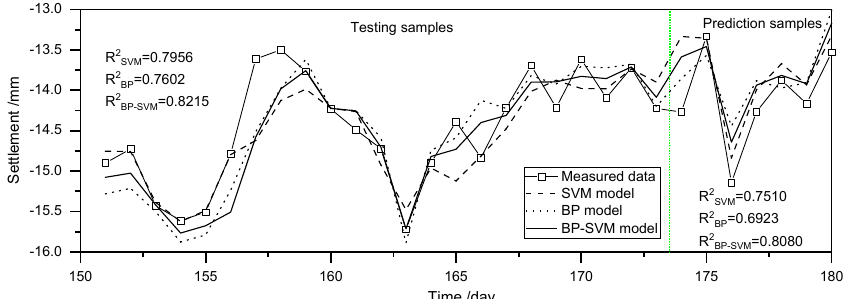
Figure 10. Prediction results for the settlement of building at JGY-22.